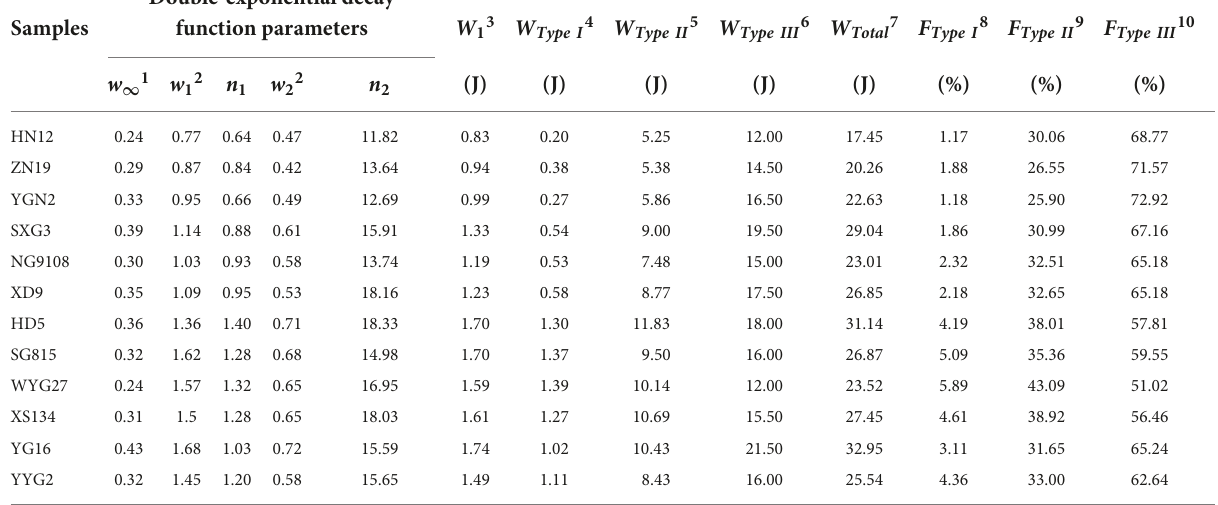
TABLE 3 Parameters from the fitting model of simulated oral processing of cooked japonica rice. Double-exponential decay